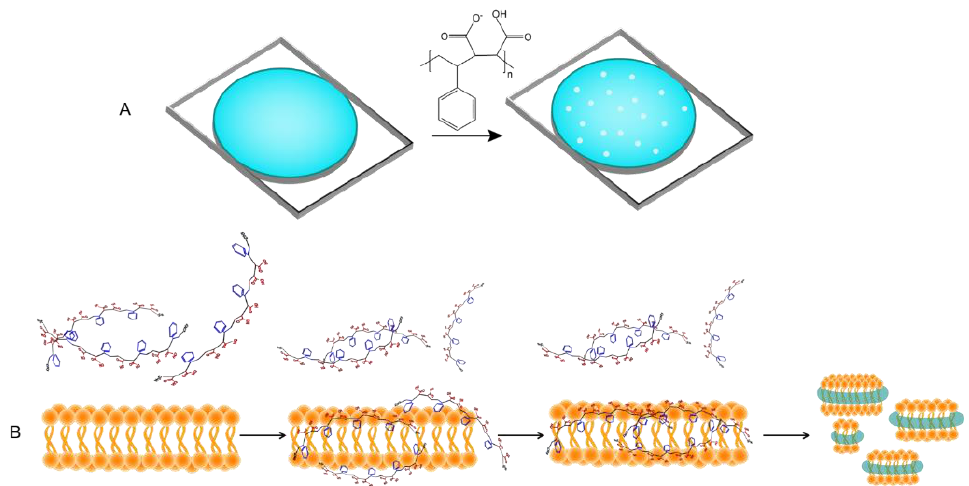
Figure 6. ( A ) SMA polymers form pores in supported lipid bilayer (shown in blue). The same process has been observed in the cells, making them permeable to water and small water-soluble fluorescent molecules ( B ) Schematic view of how encapsulation event perturbs the membrane and leads to membrane fragmentation and formation of discs.